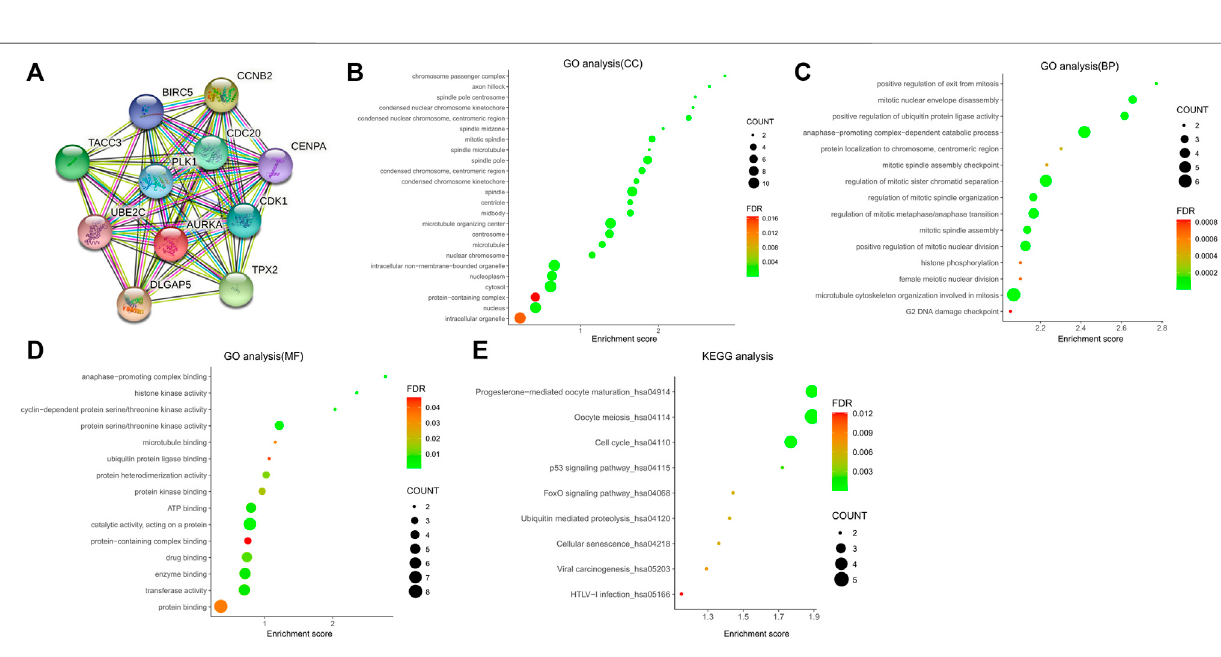
Frontiers in Genetics |